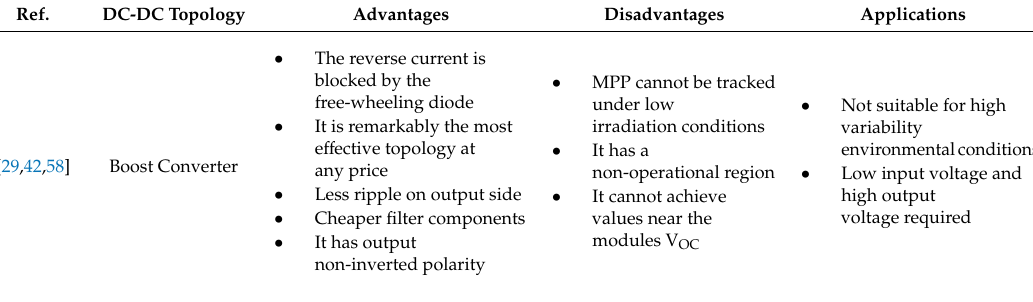
Table 2. Comparison of non-isolated DC–DC converters for the PV stage.